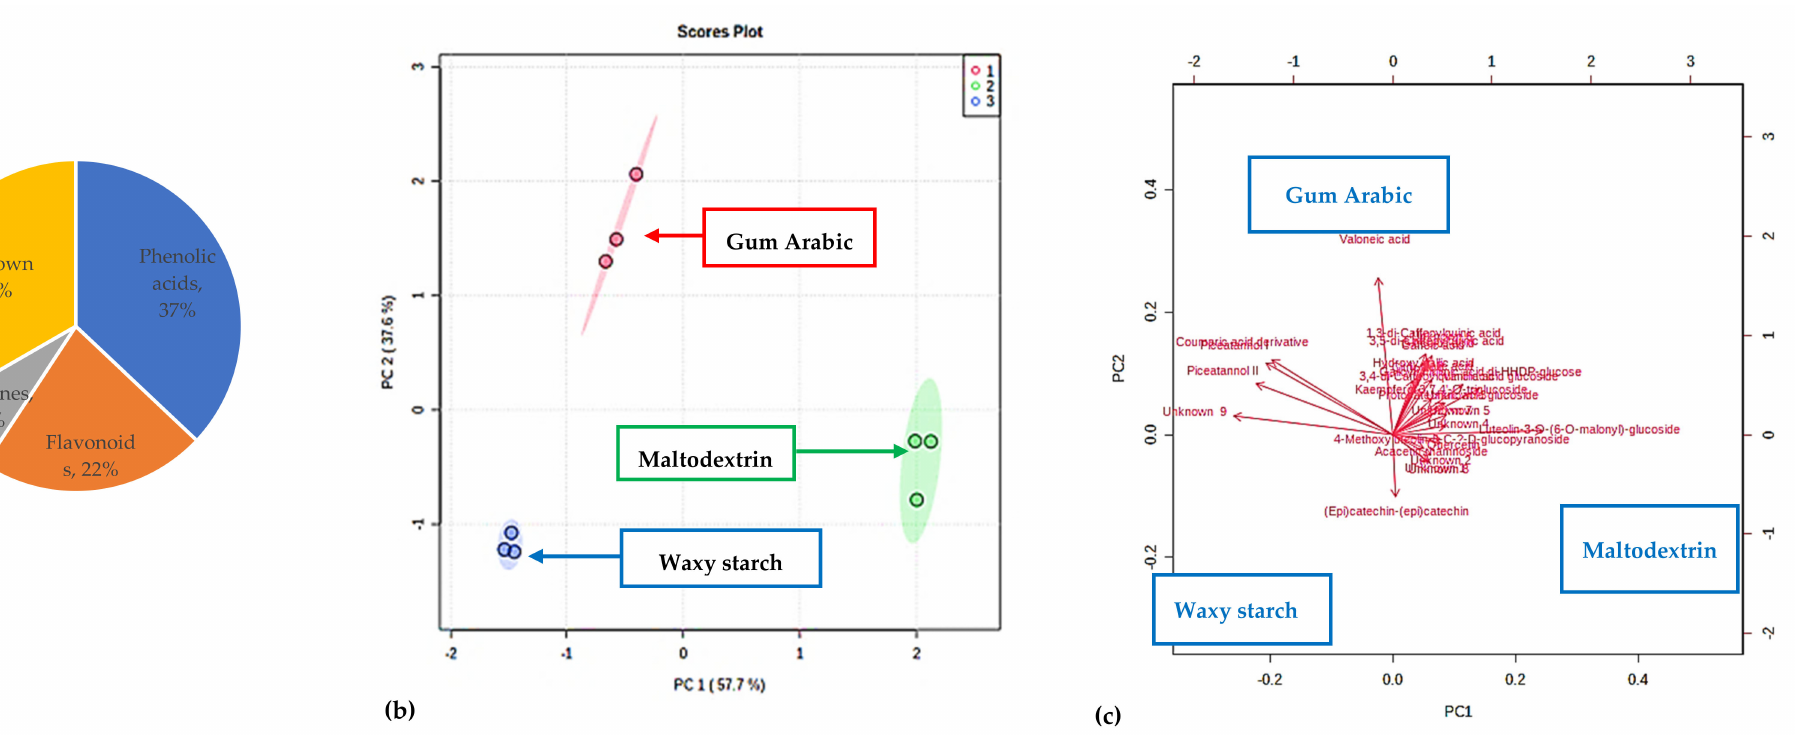
Figure 7. ( a ) Classification and proportion of the metabolites identified in the passion fruit peel powders, ( b ) principal component analysis (PCA) score plot and ( c ) PCA biplot showing potential biomarkers linked to the differences noted in passion fruit peel extracts encapsulated with gum arabic, maltodextrin, and waxy